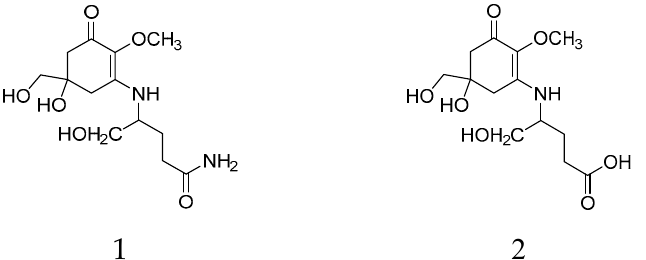
Figure 1. Chemicals structures of mycosporine glutaminol ( 1 ) and mycosporine glutamicol ( 2 ) isolated from Dermatocarpon luridum var. luridum .